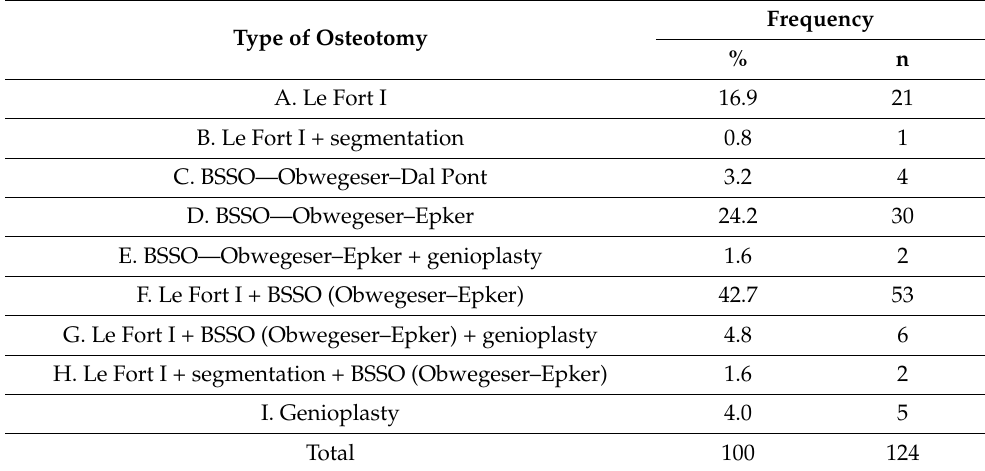
Table 6. Distribution of osteotomy applied during surgery in the study group of